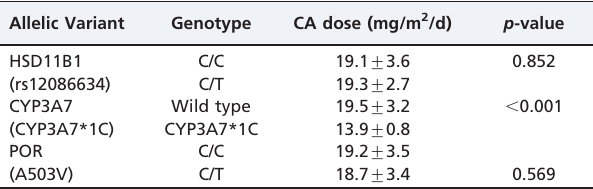
Table 2 - Mean ¡ SD daily cortisone acetate doses (mg/m 2 / day) according to genetic polymorphisms in patients with classical 21-hydroxylase